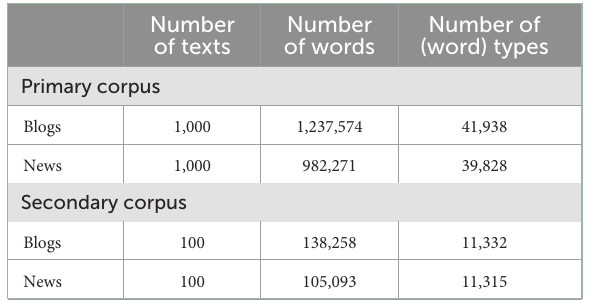
TABLE 1 Summary information of the primary and the secondary